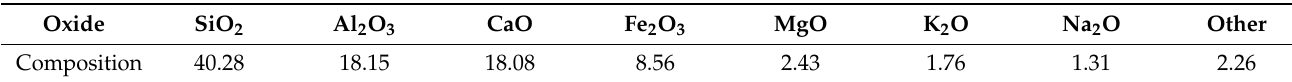
Table 4. Chemical constitution of fly ash.